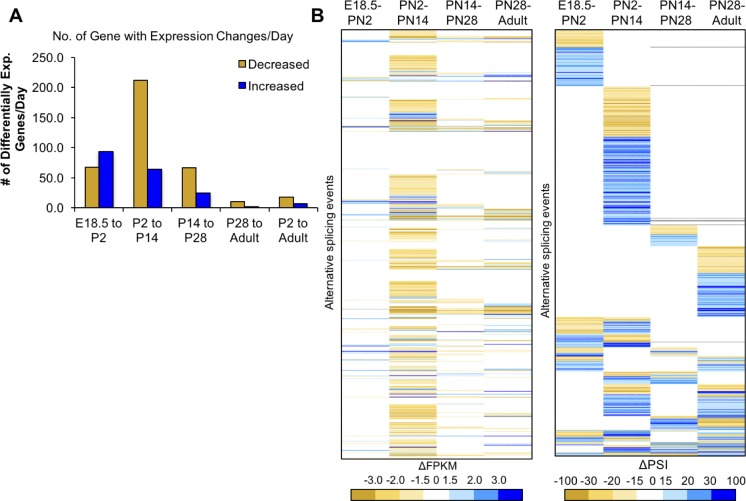
Most changes in gene expression occur before PN14.(A) Differential gene expression changes standardized to the number of days in the time interval. (B) Heat map of differential gene expression of genes (left) with alternative splicing (right) between four intervals. The gene list is aligned in the heat maps for differential expression and alternative splicing, the latter is reproduced from Figure 2C. Largest changes are denoted by the darkest colors of yellow (decreased) or blue (increased). White indicates unchanged.